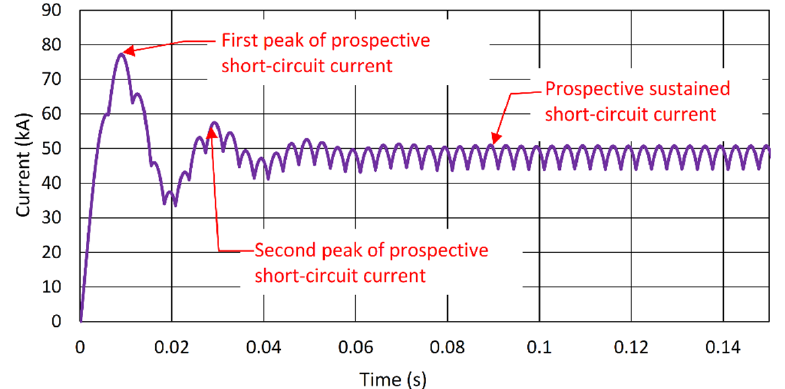
Figure 1. Bolted short-circuit fault current simulation results.